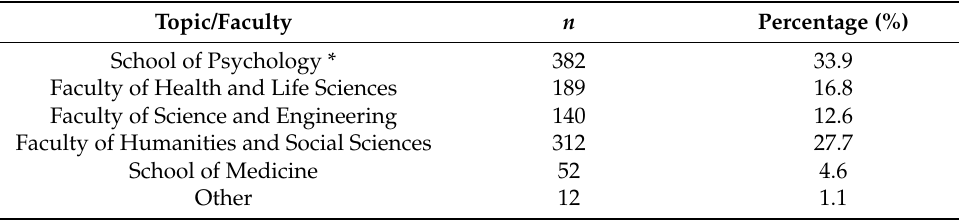
Table 1. Breakdown of responses based on discipline ( N = 1087).